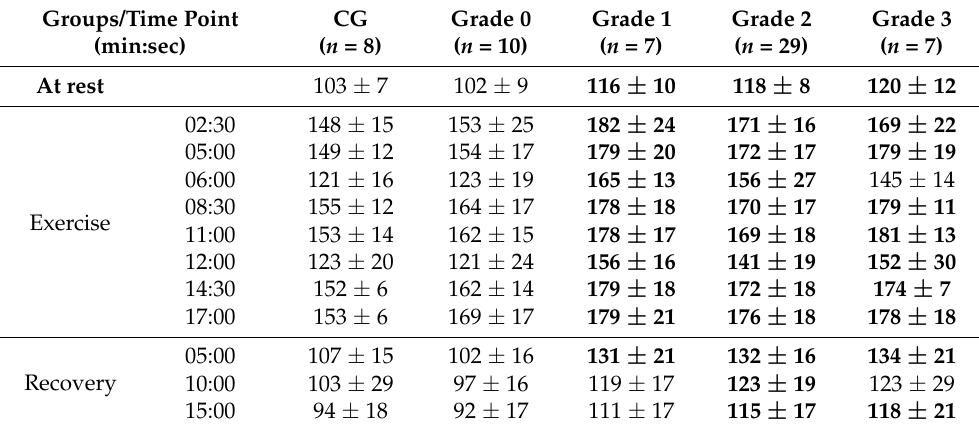
Table 5. Heart rate (mean ± SD) of dogs in the control group (CG) and pugs subdivided into BOAS grades 0–3.